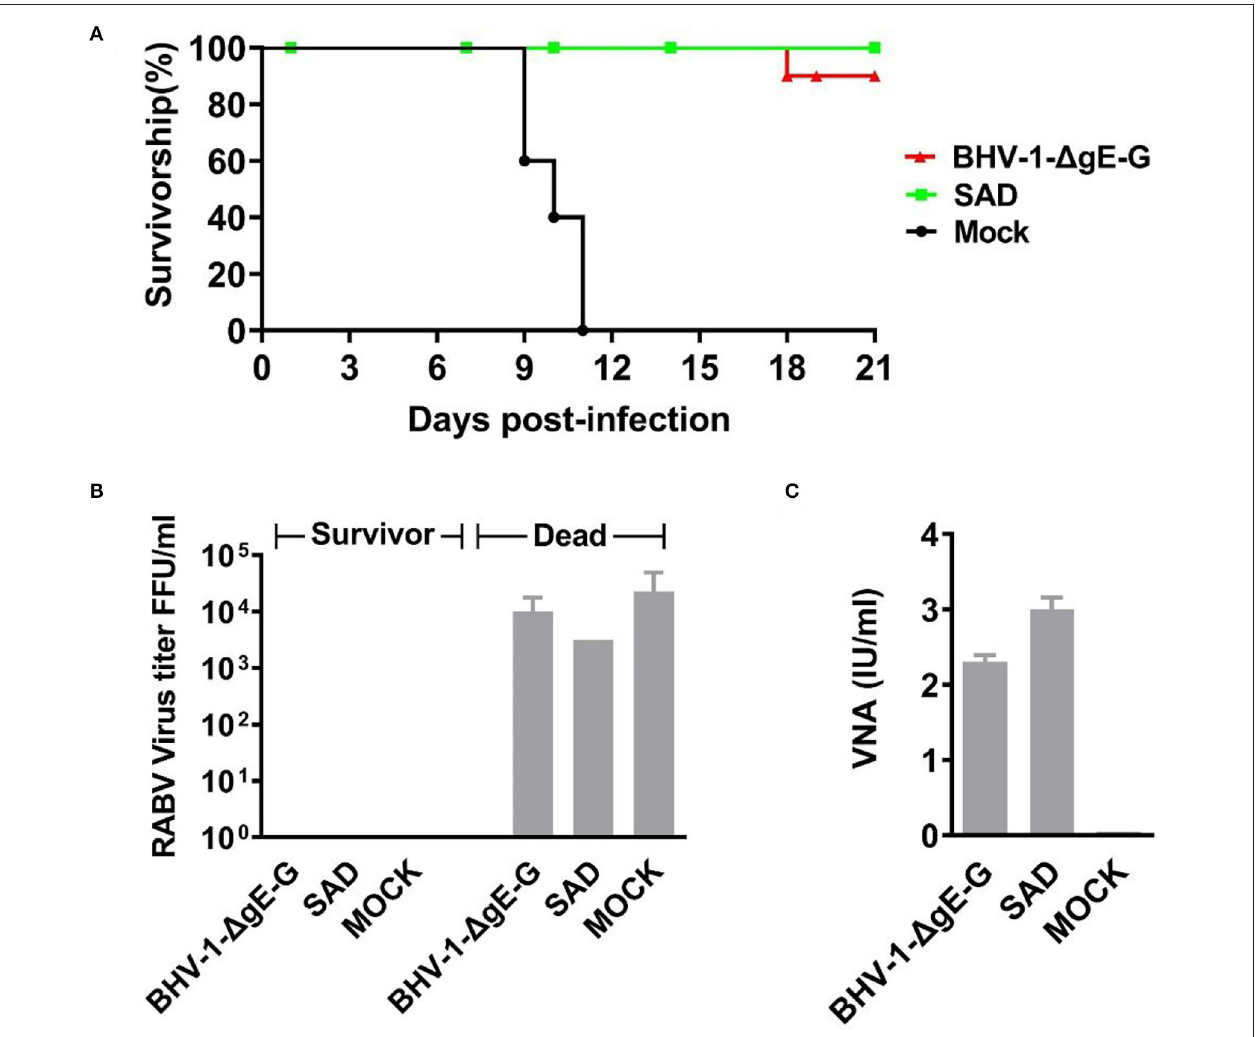
FIGURE 4 | Survival rate and VNA of mice post-challenge. (A) Six-week-old female ICR mice were randomly divided into three groups, and each group included 10 mice. Each group of mice was inoculated once with 10 5 PFU of BHV-1- 1 gE-G, 10 5 FFU of SAD or medium control, respectively. Each mice was inoculated with 20 µ l of virus, 10 µ l for each hind leg. All mice received a challenge with 50 LD50 CVS-24 via an IM route at 21 days post-immunization. Mice were seen to be moribund or that had lost more than 30% of their starting body weight were humanely euthanized. The number of euthanized mice and the corresponding days of death were observed, and the results were graphed by GraphPad Prism 5.0 software. (B) Virus titers in the brains of surviving and dead mice. (C) VNA in the serum of dead and surviving